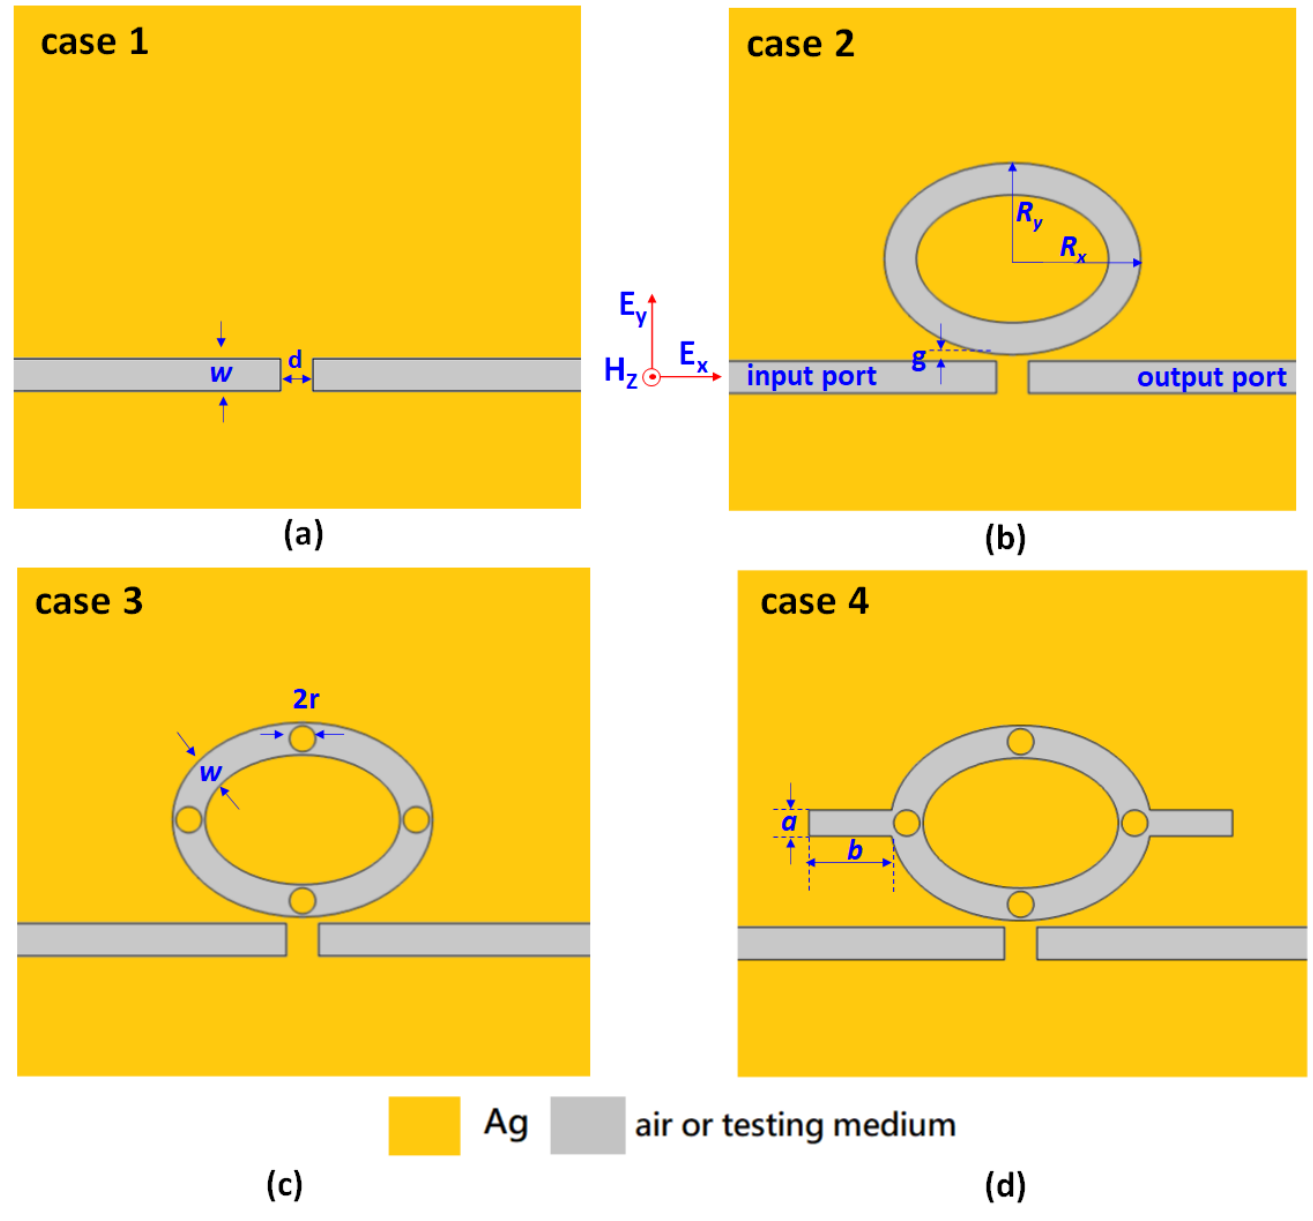
Figure 1. Top view of the designed MIM plasmonic sensors: ( a ) case 1, ( b ) case 2, ( c ) case 3, and ( d ) case 4, respectively. Where H z , E y and E x represent the magnetic field component along z-axis, electric field component along y-axis and electric field component along x-axis, respectively.